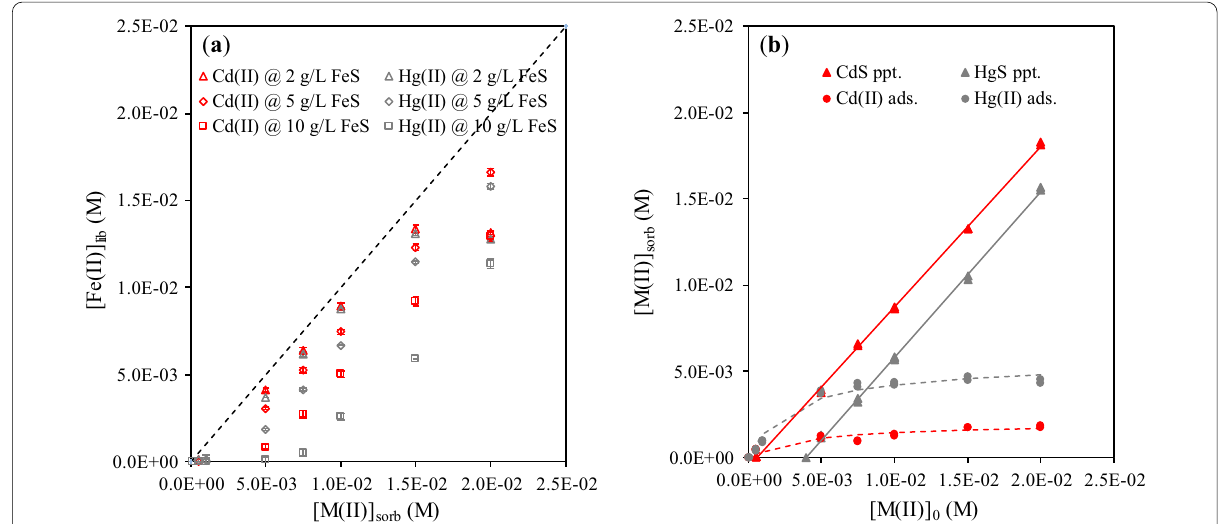
Fig. 2 Liberated Fe(II) concentration ([Fe(II)] lib ) versus sorbed M(II) concentration ([M(II)] sorb ) at pH 5.5–6.0 ( a ) and sorbed M(II) concentration ([M(II)] sorb ) versus initial M(II) concentration ([M(II)] 0 ) in 10 g/L FeS batches at pH 5.5–6.0 ( b ). In part a , error bars indicate one standard error. In part b , solid and dashed lines represent linear and Langmuir‑like fits, respectively. Hg(II) sorption data are from Jeong et al.